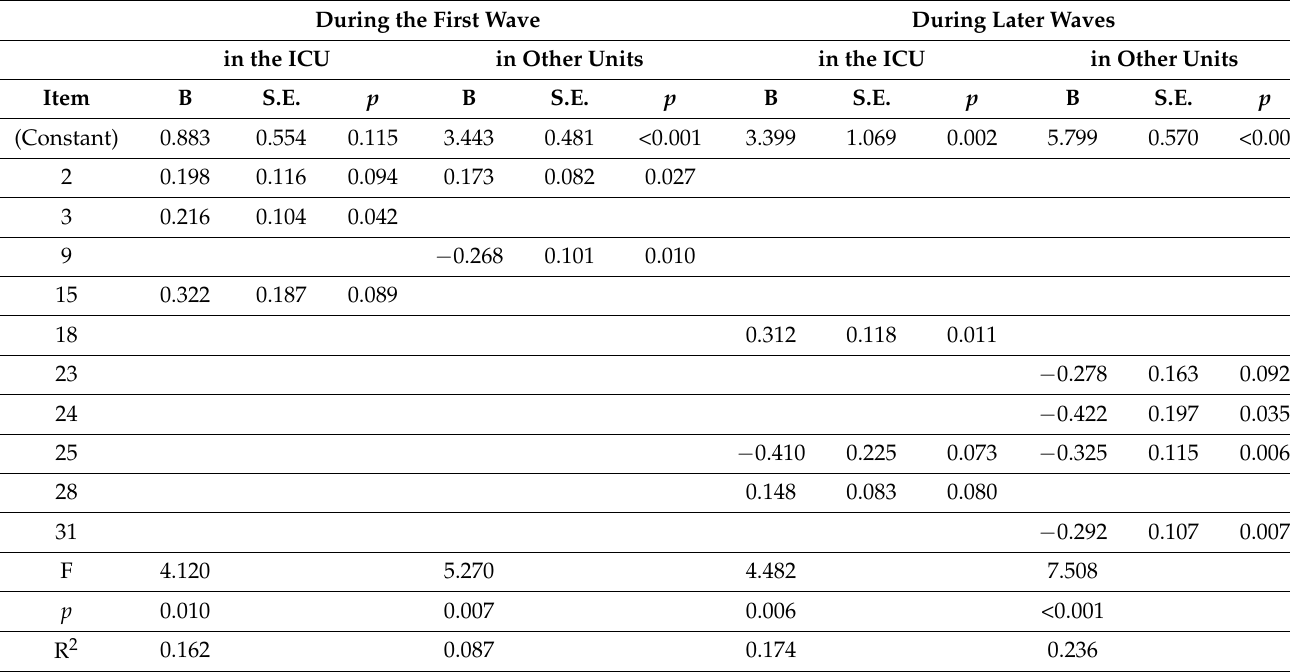
Table 3. The final regression analysis results of the managers’ satisfaction with the hospital’s manage- ment of